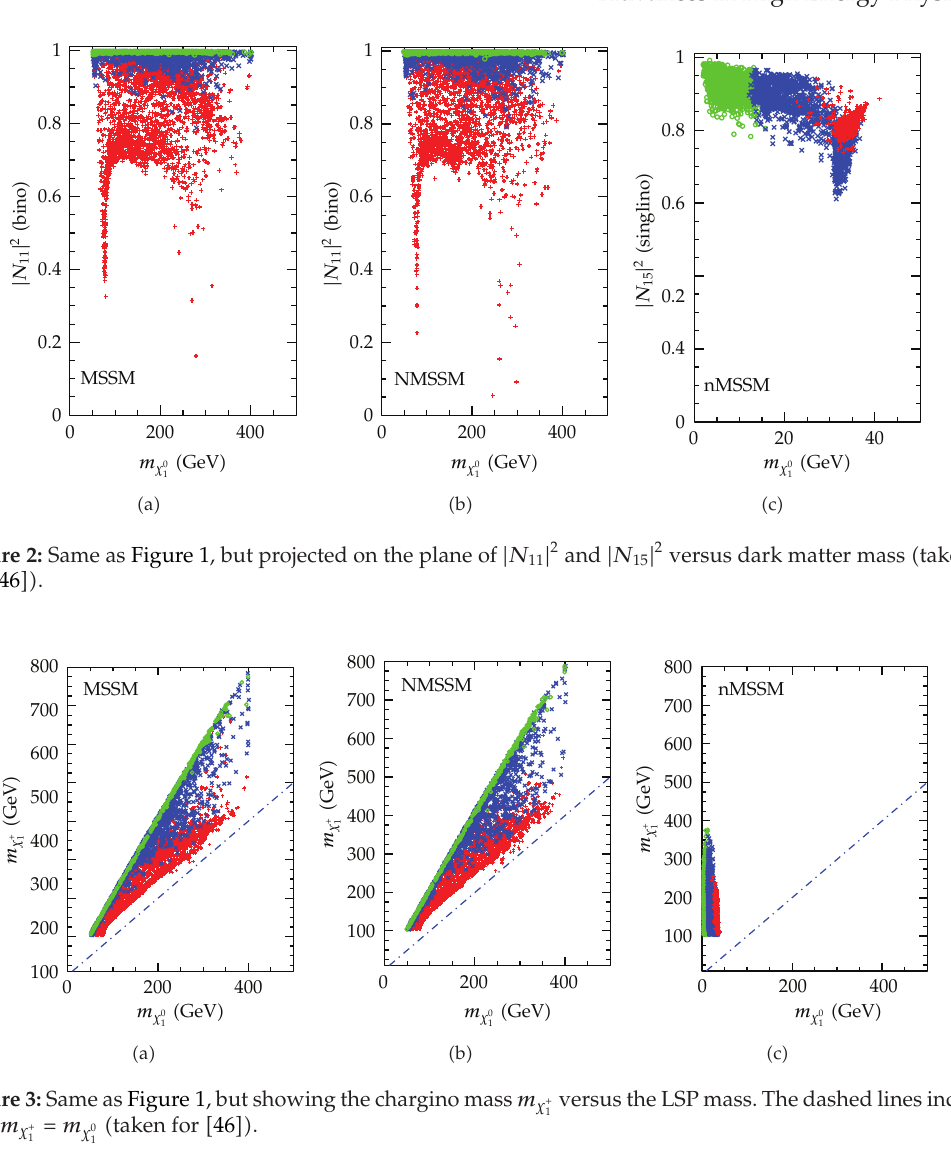
versus the LSP mass. The dashed lines indi- 1